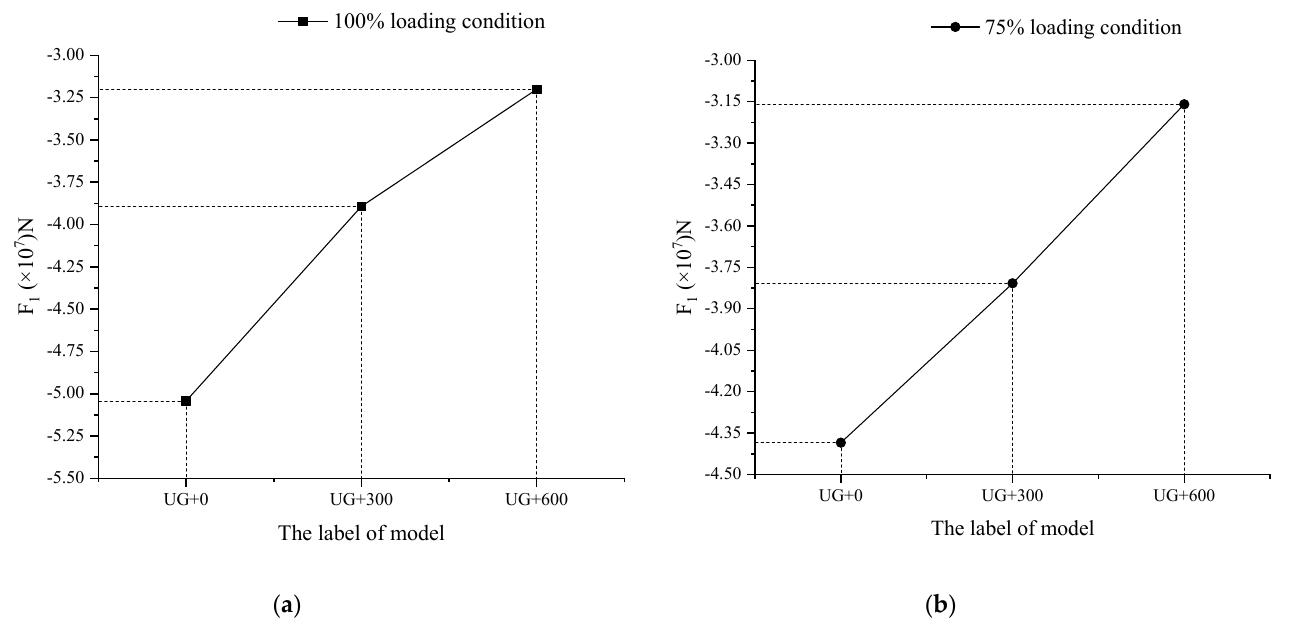
Figure 7. Comparison of F 1 . ( a ) 100% loading condition. ( b ) 75% loading condition. Taking the 100% load condition as an example, the pressure distribution inside the crown clearance is analyzed, as shown in Figure 8. It can be seen from the figure that when the fluid flows into the clearance from the runner, the pressure is higher, and the pressure decreases after passing through the labyrinth ring, i.e., the change of the position of the labyrinth ring in the crown clearance causes the internal pressure to be divided distinctively into high- and low-pressure areas. When the labyrinth ring moves away from the central axis, the value of L decreases, i.e., the high-pressure area decreases, and the crown clearance produces downward axial water on the runner, so the thrust is reduced. The major influence on the resultant axial hydraulic thrust is actually the change of F 1